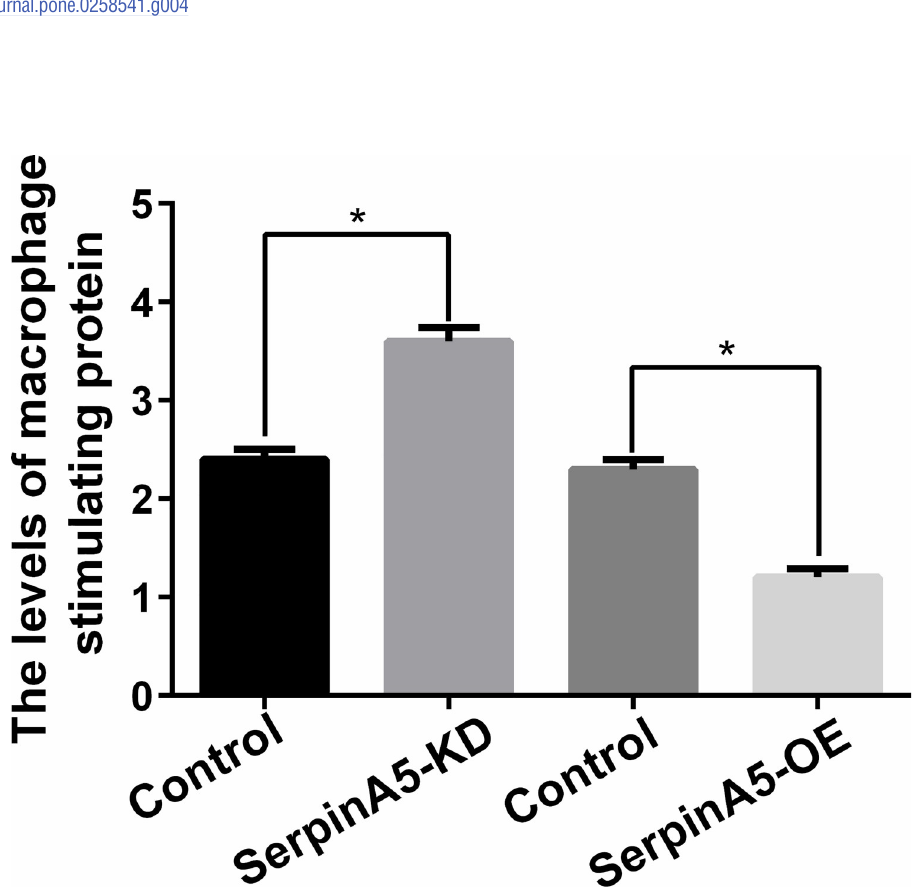
Fig 5. Simple mechanism analysis. SerpinA5 may be able to negatively regulate the macrophage stimulating protein (MSP) and MSP could be the target of SerpinA5.